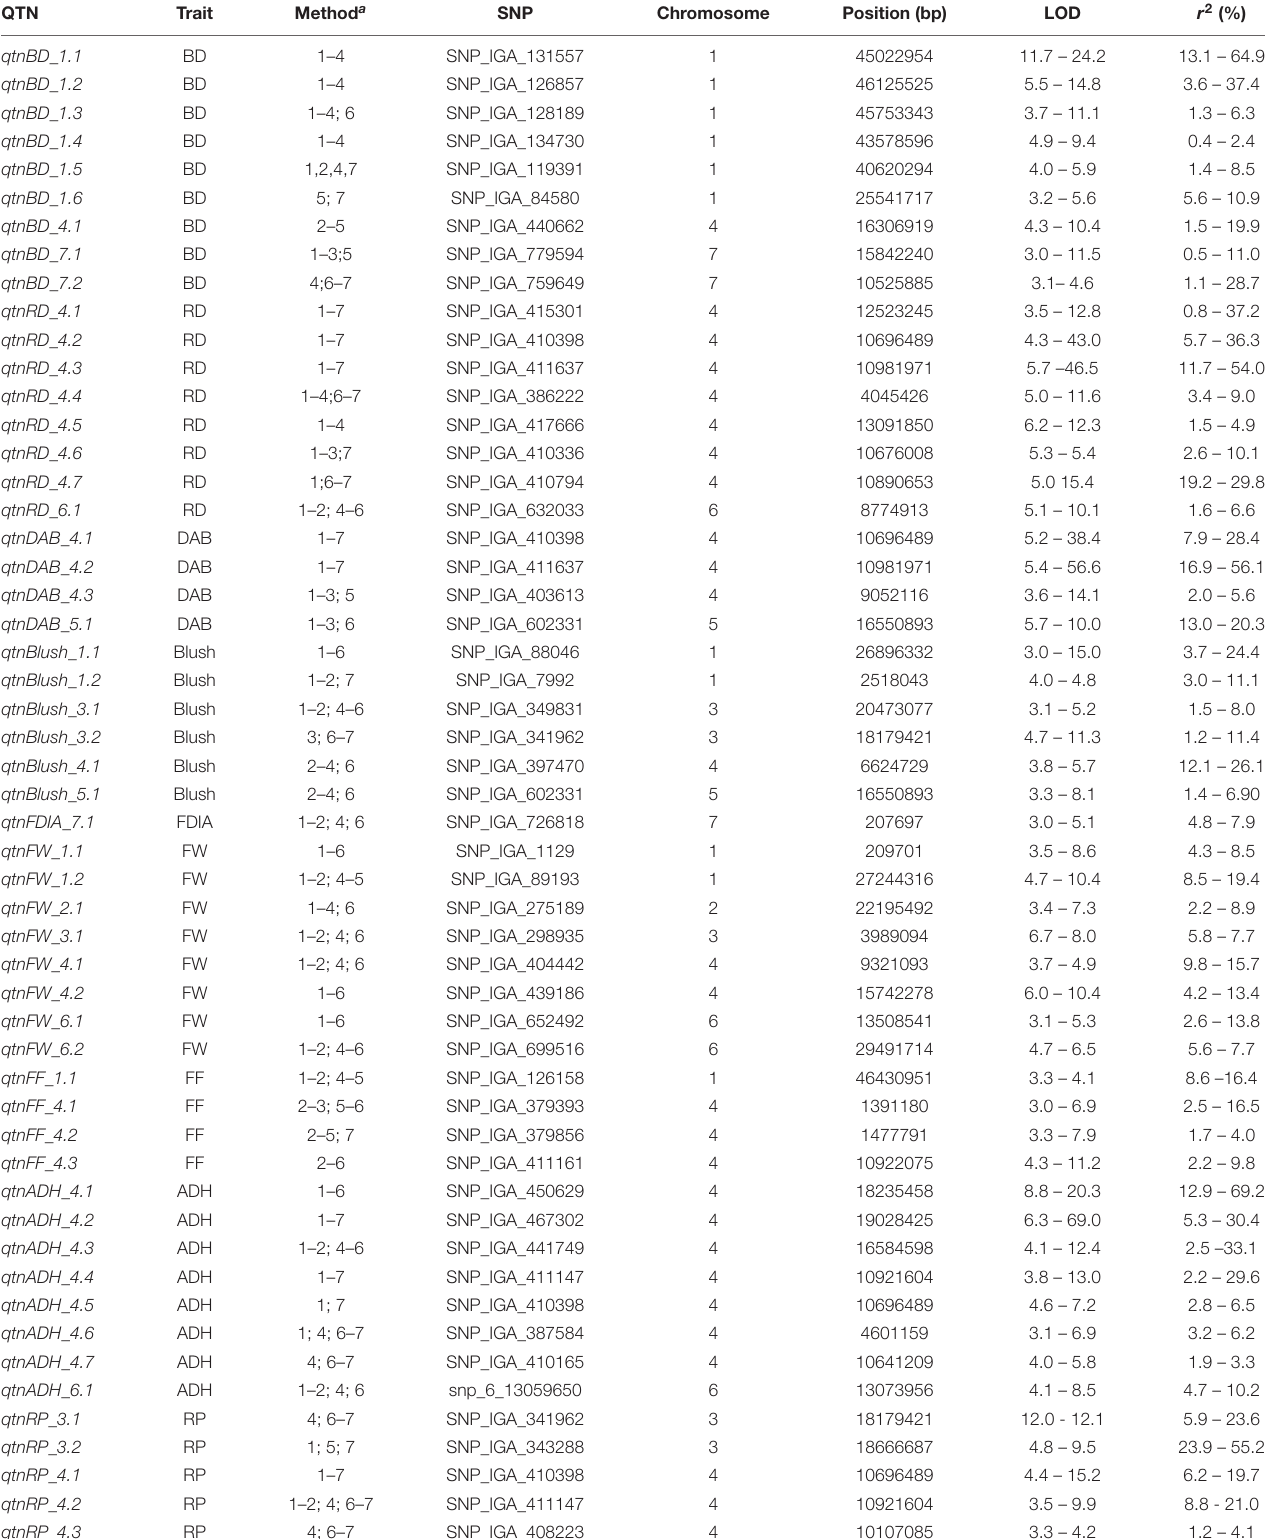
TABLE 2 | Significant associations between SNP markers and quality traits detected in at least three methods of mrMLM 4.0 and/or two